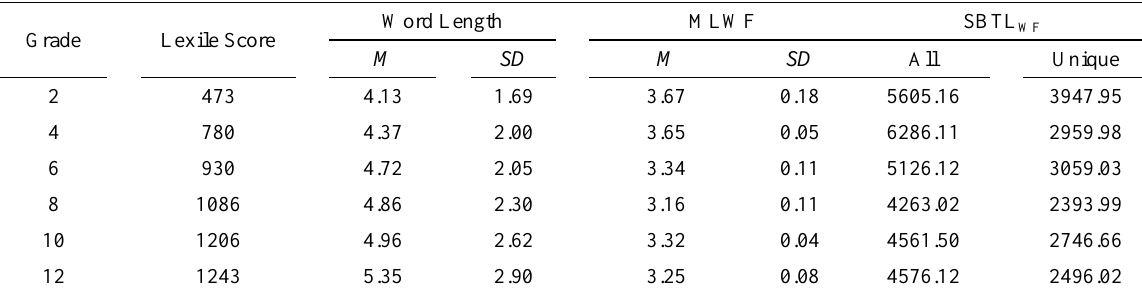
Table 1. Lexile Scores, Mean Word Lengths, and Word Frequencies of Passages